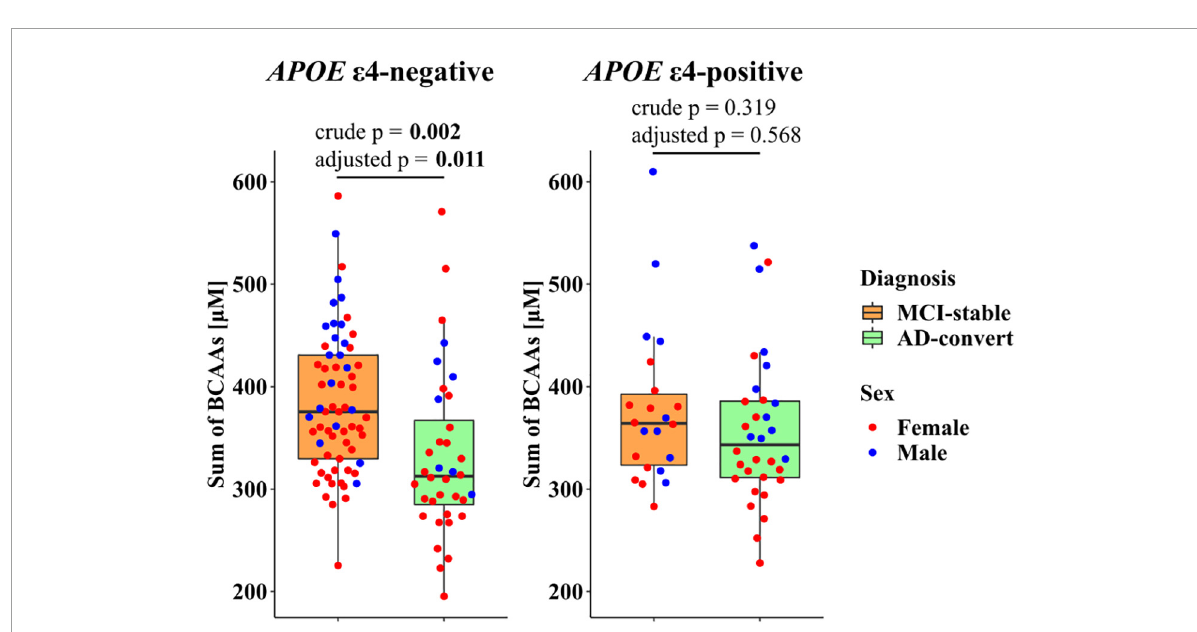
FIGURE3 Stratified analysis of plasma branched-chain amino acid (BCAA) concentrations in mild cognitive impairment (MCI) individuals by apolipoprotein E ε 4 ( APOE ε 4) positive/negative status. Red and blue dots represent females and males, respectively. Crude p : p- value calculated based on the logistic regression model with no covariates. Adjusted p : p- value calculated based on the logistic regression model adjusted for age, sex, and BMI. Bold text indicates statistical significance according to a p- value less than